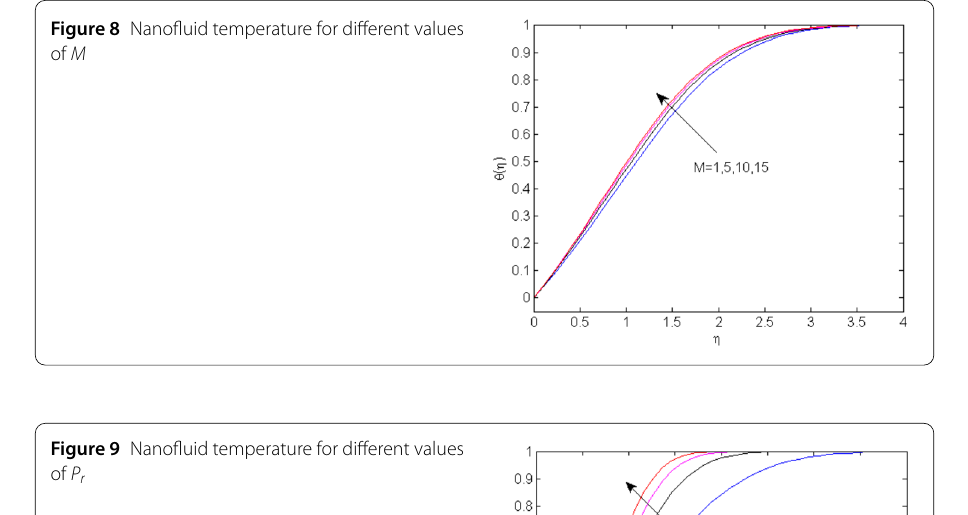
Figure 8 Nanofluid temperature for different values of M